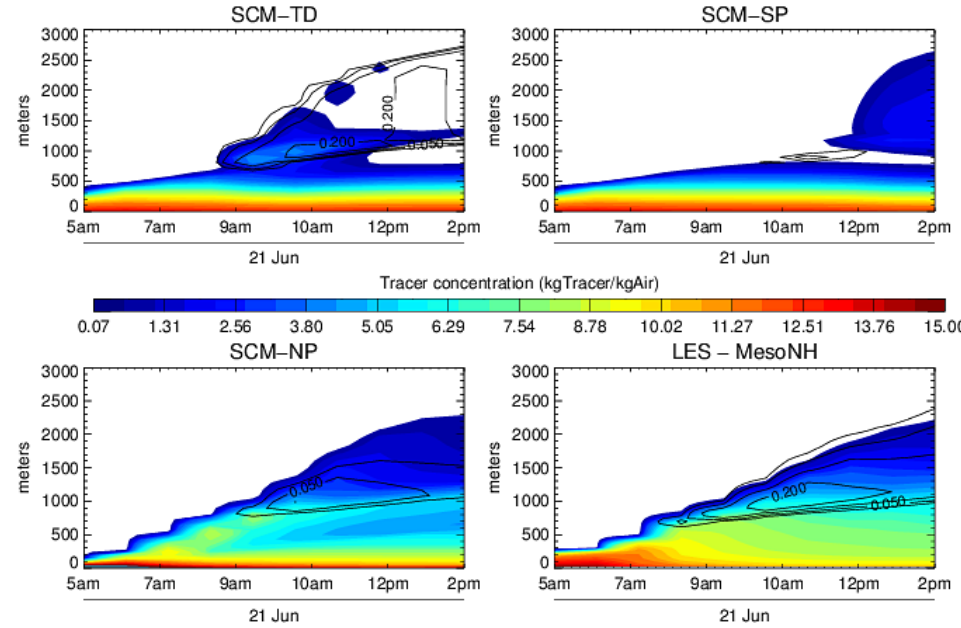
Figure 1. Atmospheric transport of an ideal tracer simulated by three different versions of a single-column configuration of LMDz model (SCM-TD (top left), SCM-SP (top right) and SCM-NP (bottom left)). These one-dimensional simulations are compared with a Large Eddy Simulation simulation (bottom right) of Meso-NH. The tracer is emitted at the surface and has a half-time life of 15min in the atmosphere. This case represents an ideal shallow convection over land case at the Southern Great Plains of the Atmospheric Radiation Measurement site on 21 June 1997. Black contours represent the total cloud cover (in fraction of the grid cell). Contour values are 0.025, 0.05, 0.1 and